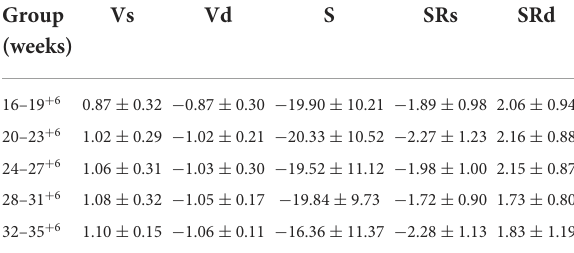
Vs,peaksystolicvelocity(cm/s). Vd,peakdiastolicvelocity(cm/s). S,strain(%). SRs,systolicstrainrate(S − 1 ). SRd,diastolicstrainrate(S − 1 ).